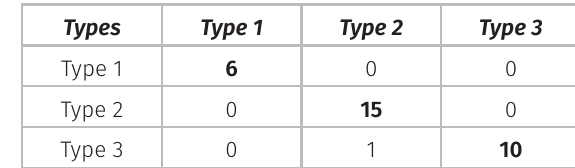
Table III. Confusion Matrix of